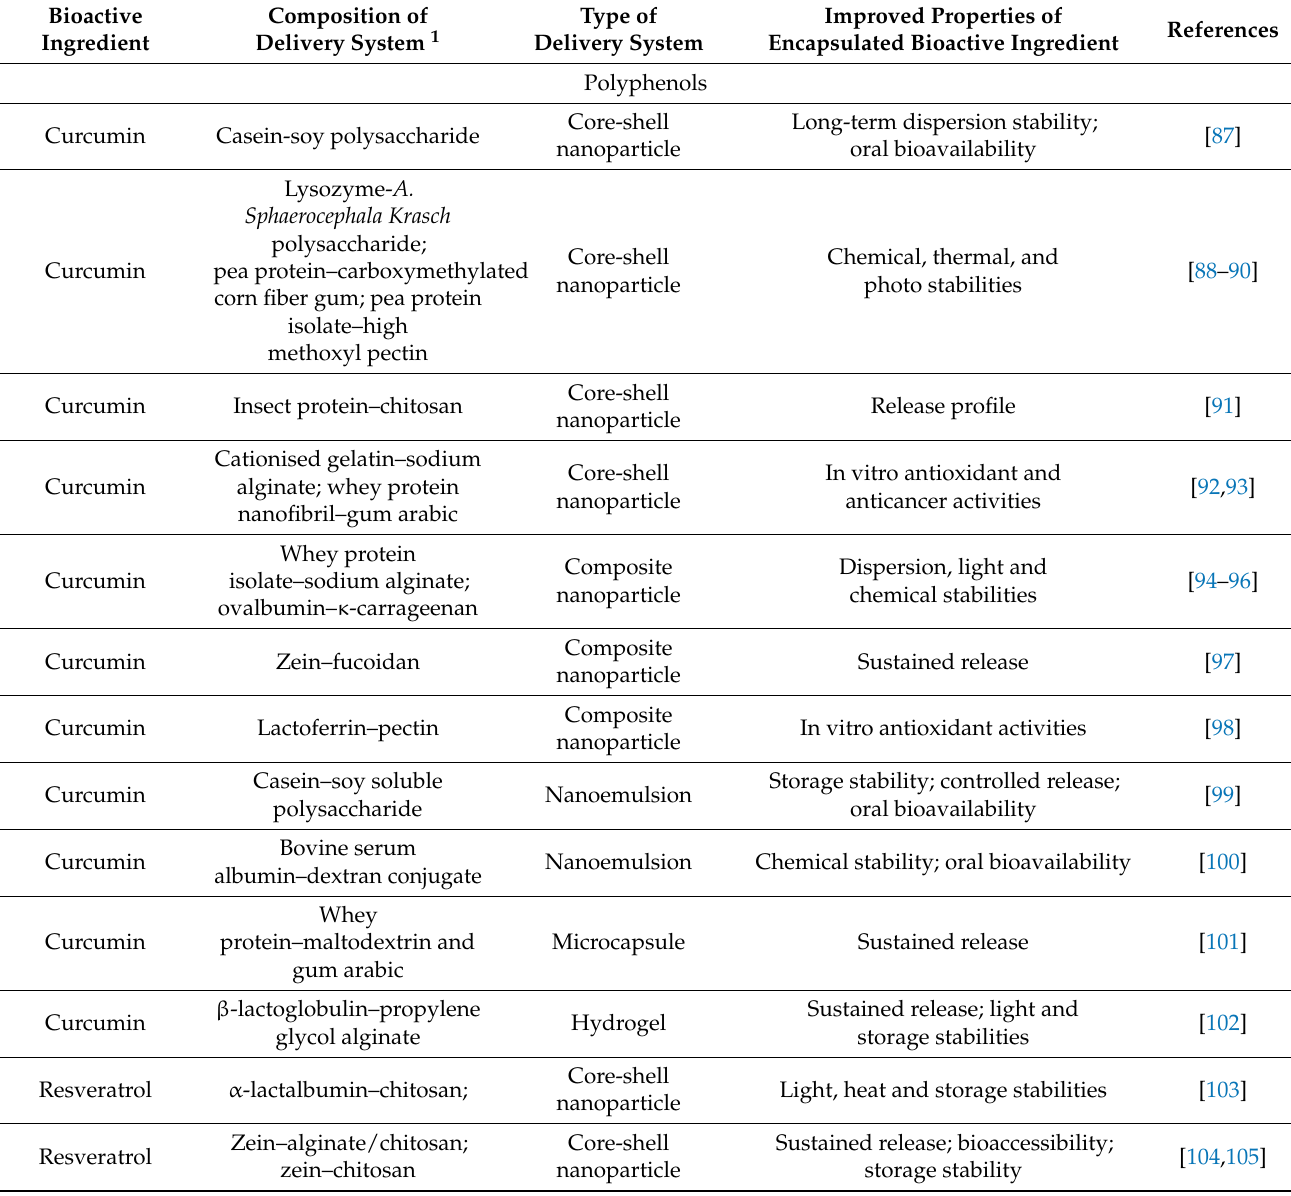
Table 3. Applications of protein–polysaccharide complexes/conjugates as delivery systems for representative food bioactive